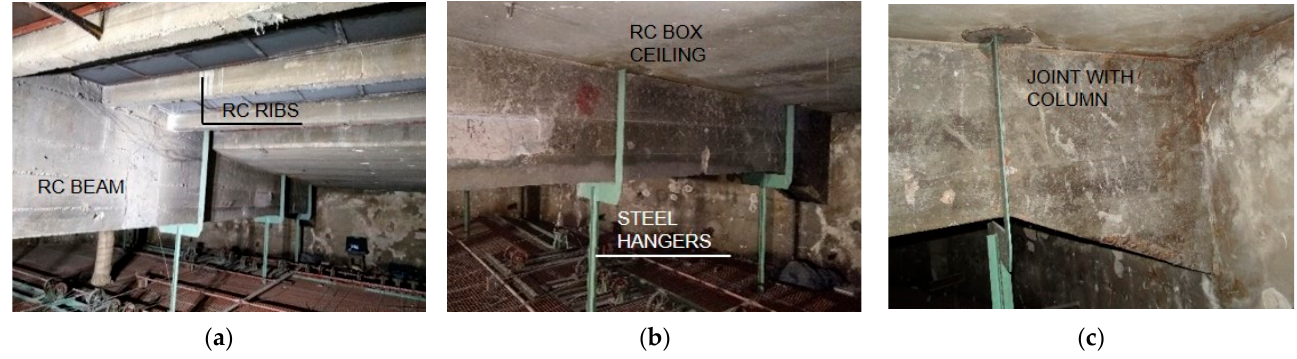
Figure 2. View of the beams: ( a ) at the skylight location; ( b ) near the column support; ( c ) connection to the column.